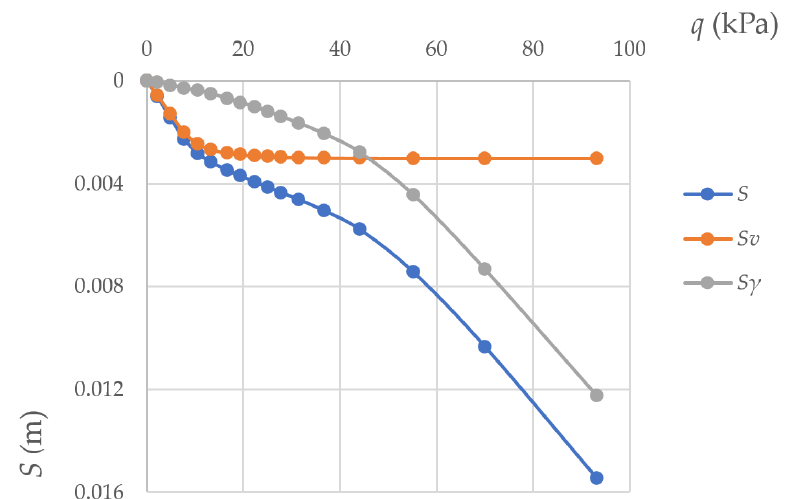
Figure 5. The dependency curves for S γ , S v , and S calculated using Equations (20) and (21) and the load q at d 1 = 6 m when the distance between the fence wall and the point of application of the distributed load is d 1 = 6 m.